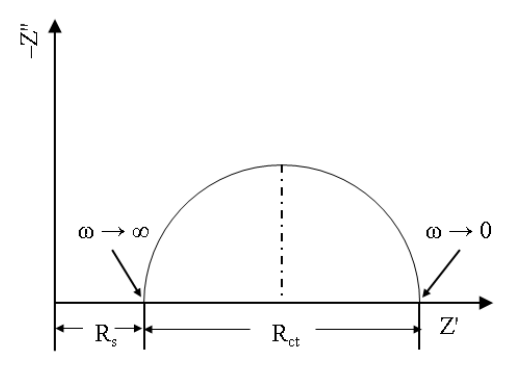
Figure 6. Schematic diagram of electrochemical impedance spectroscopy.